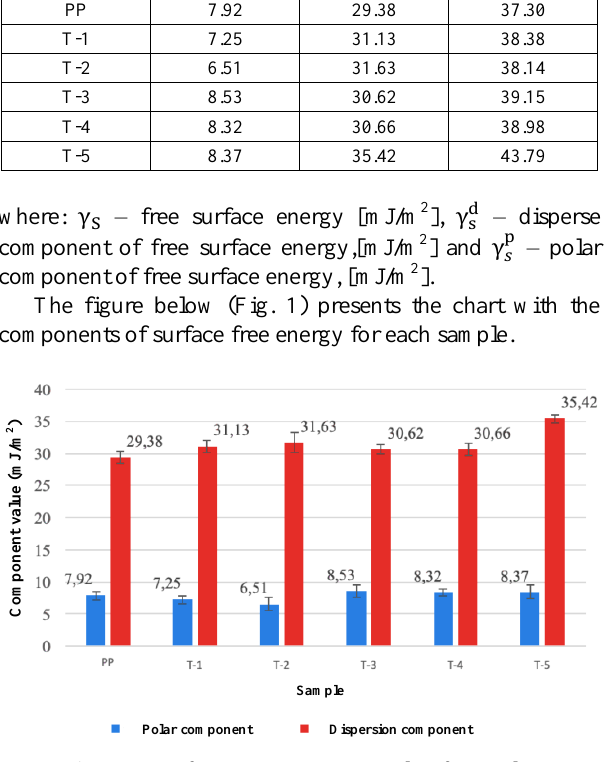
Fig. 1. Free surface energy components values for samples The measurement results indicate high values of the dispersive component which is the derivative of dispersion interactions between molecules. At the same time, the very small value of the polar component is maintained, that tells about the uneven distribution of atoms, hence its value should be as low as possible because it affects the phenom- enon of wetting and formation of the hydration layer on the surface of a solid. The total value of the surface free